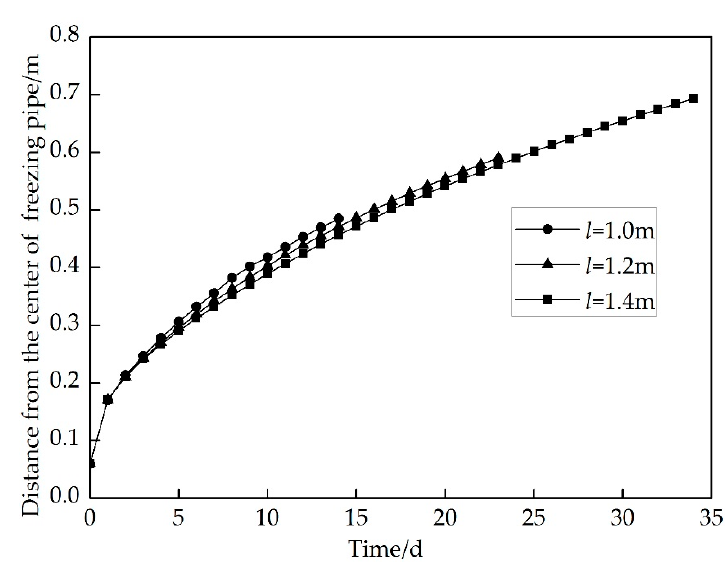
Figure 11. The time–history curve of freezing front.